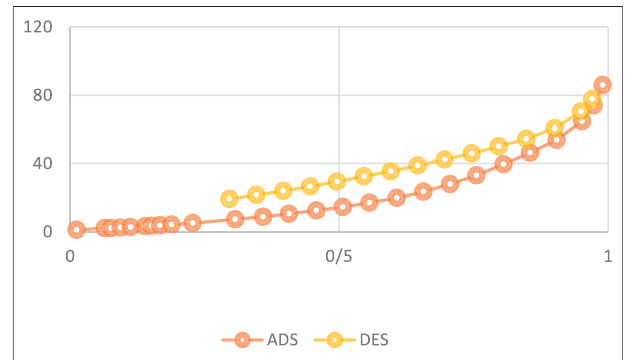
FIGURE 8 | N 2 adsorption/desorption isotherms of Y-MOF synthesized under the optimal condition of the microwave route.